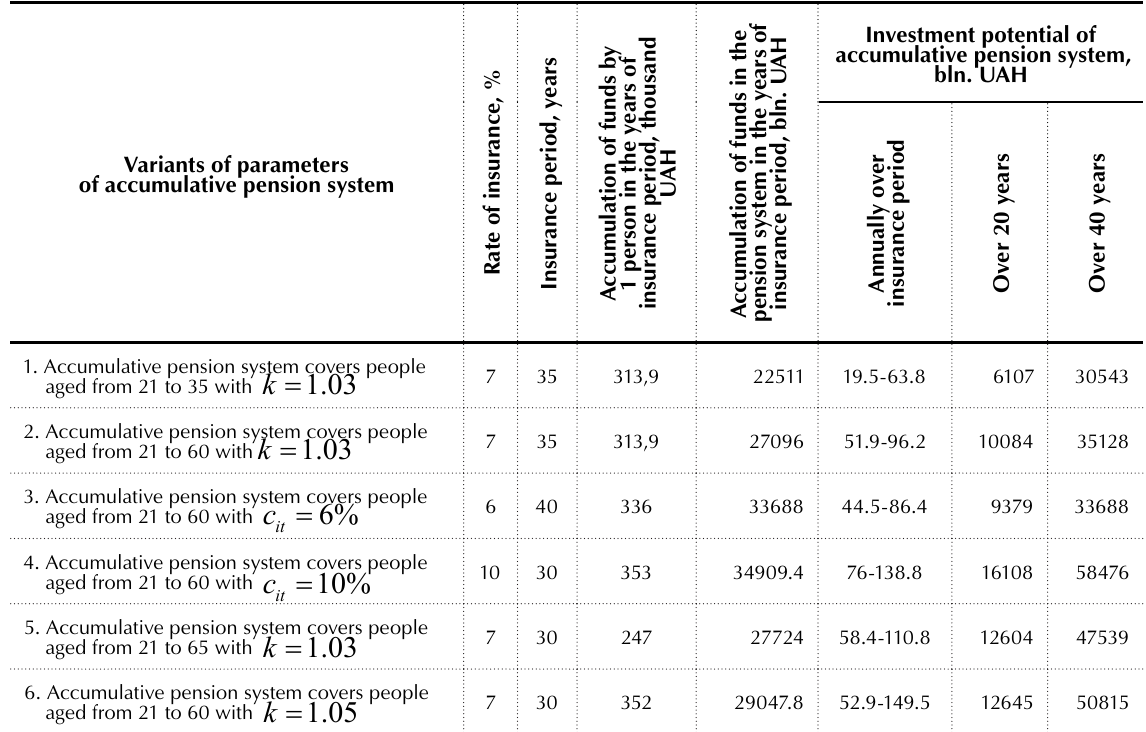
Table 2. The results of calculations of some versions in the functioning of the accumulative pension system